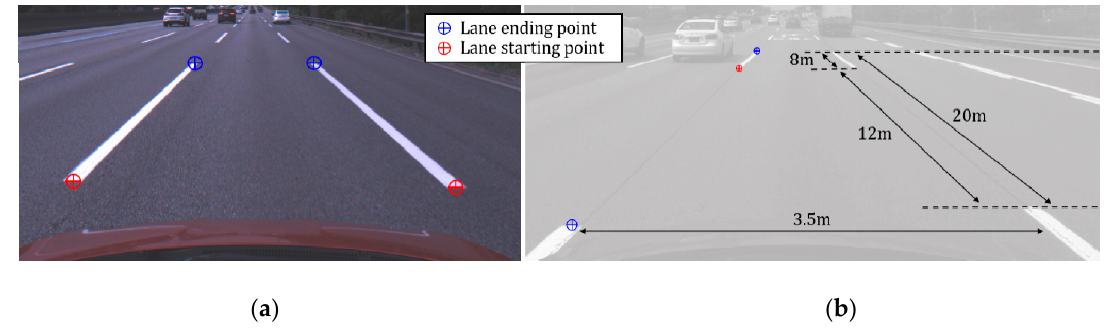
Figure 2. ( a ) Two types of lane endpoints; ( b ) Installation regulation of dashed lane marking.